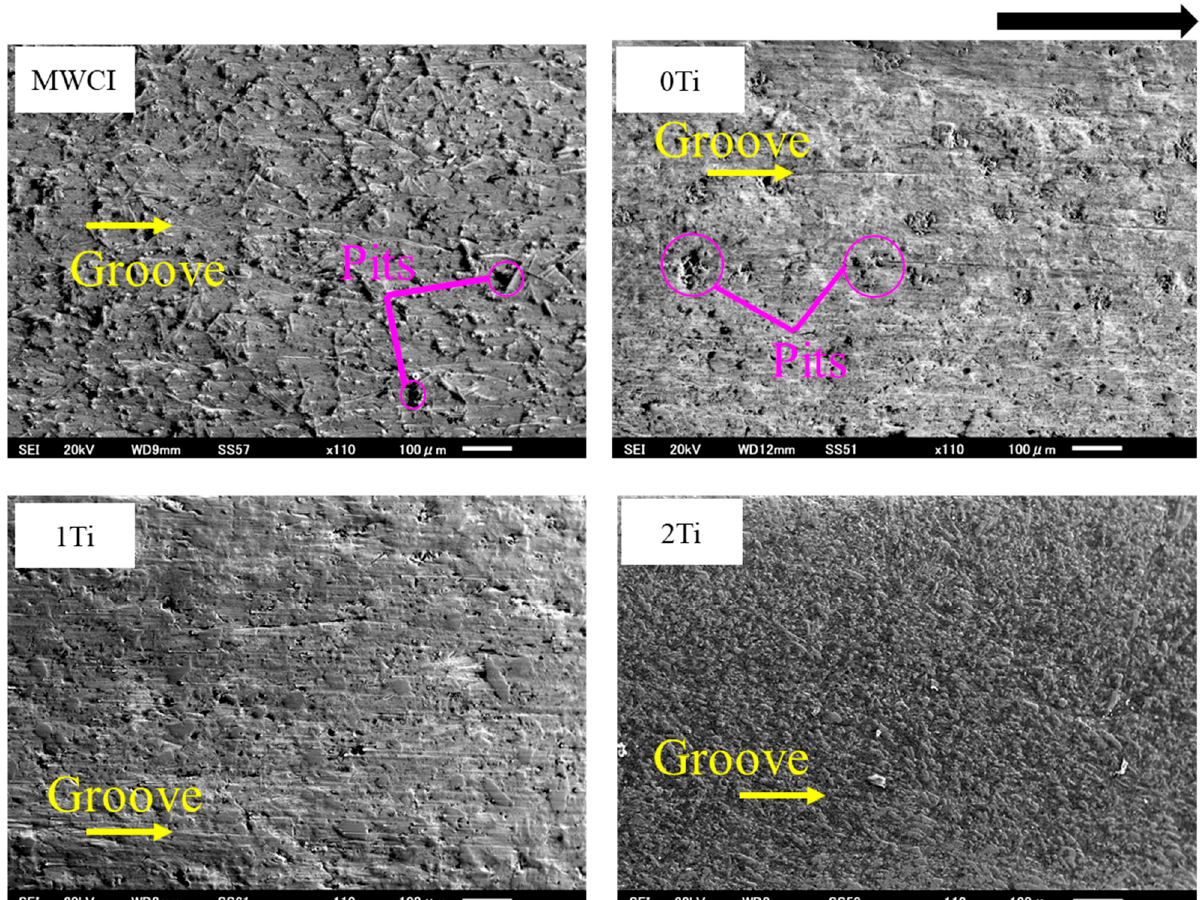
Figure 10. The worn surface of each specimen after being tested with silica sand ϕ 300 μ m.